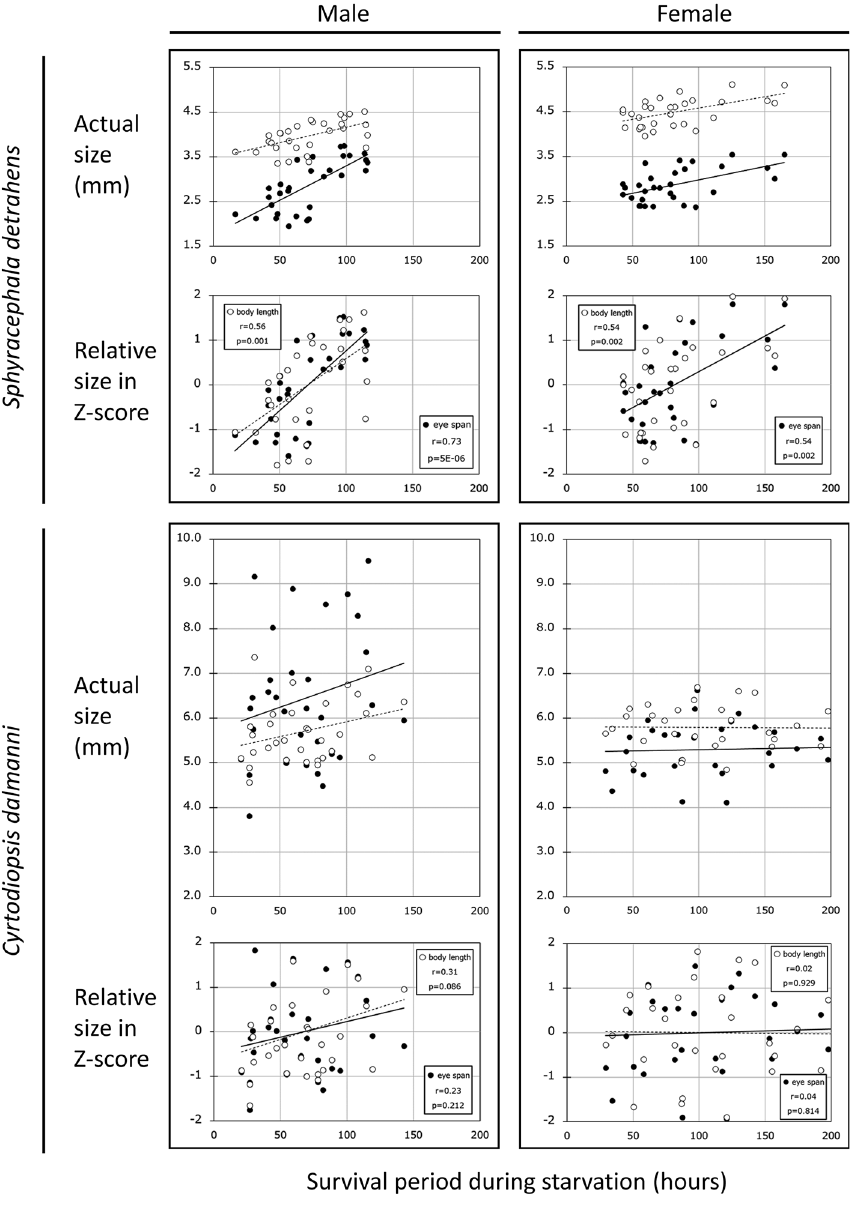
Figure 3. Relationship between starvation tolerance and trait size in both S. detrahens and C. dalmanni . In S. detrahens and C. dalmanni , the survival periods of both sexes after the initiation of starvation were measured, and their relationships with eye span (closed circles with solid approximation lines) and body length (open circles with broken approximation lines) are shown (actual size is shown the in upper and Z-scores in the lower graphs, respectively) in each dataset (enclosed by rectangles). The approximation lines were created by ordinary least squares. Both the correlation coefficients (r) and P values (p) were the same between the actual size and